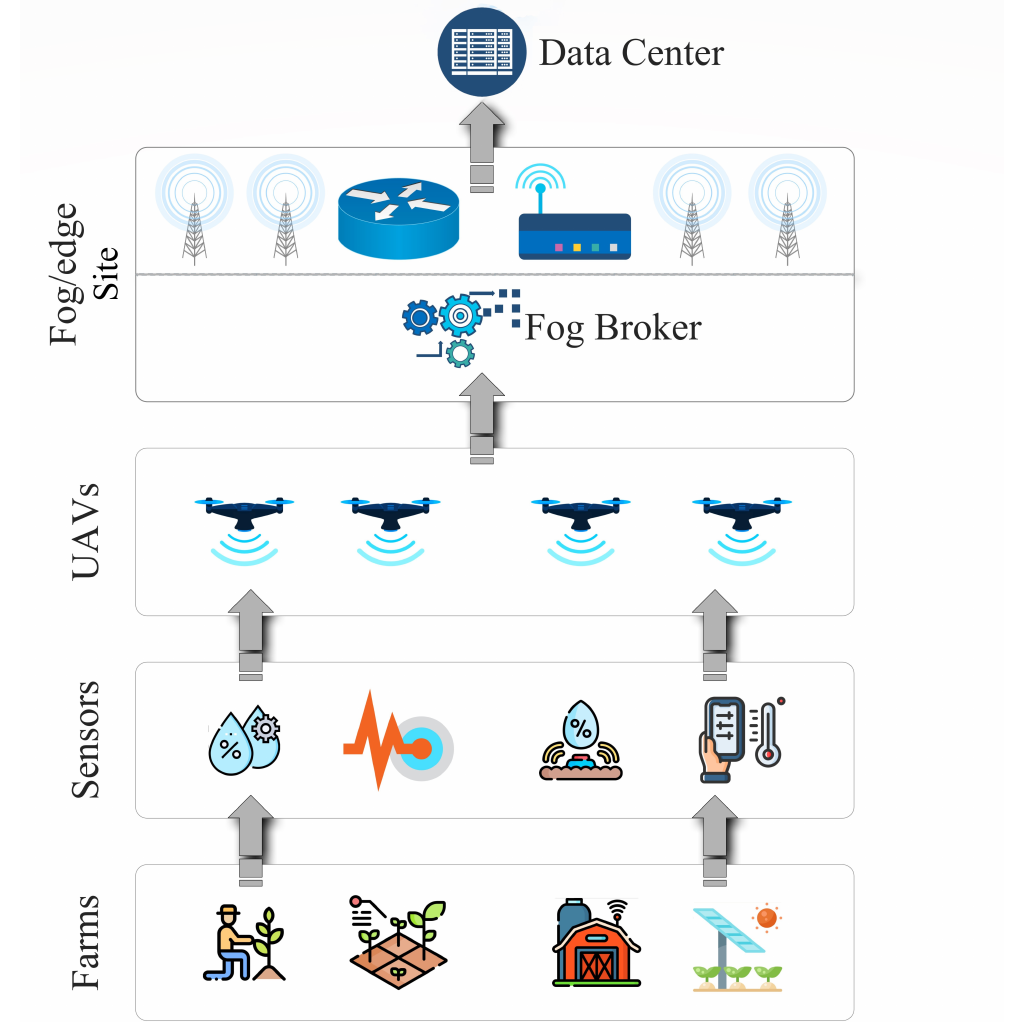
Figure 2. Fog-based layered